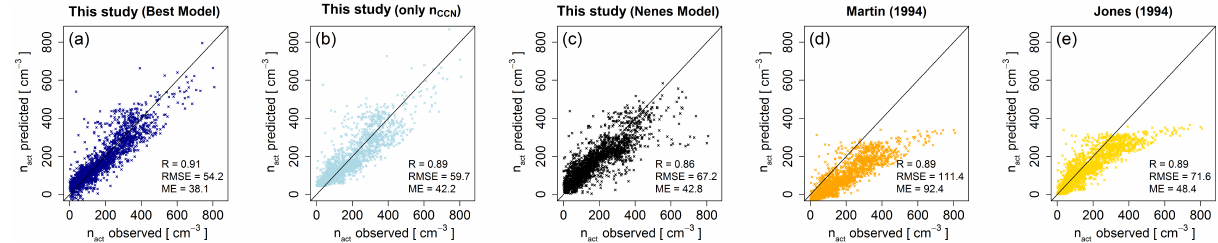
Figure 16. A comparison of the statistical models developed in this study, and the microphysical parametrization, with the performance of two existing models by Martin et al. (1994) and Jones (1994), which are based only on n CCN